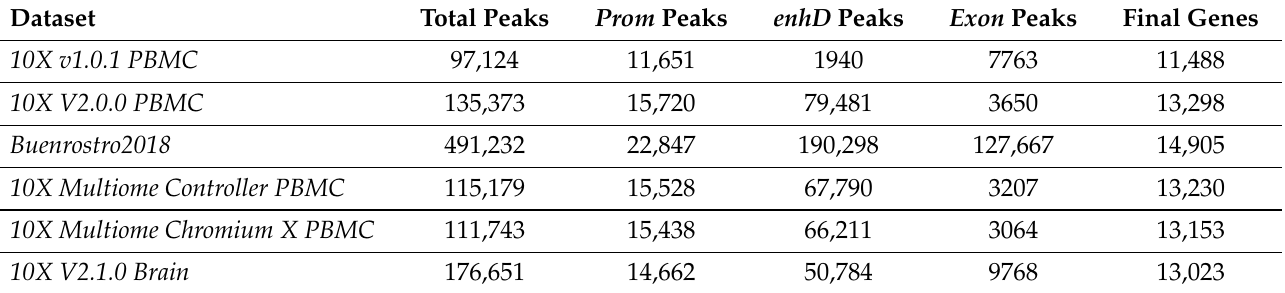
Table 3. Numbers of peak